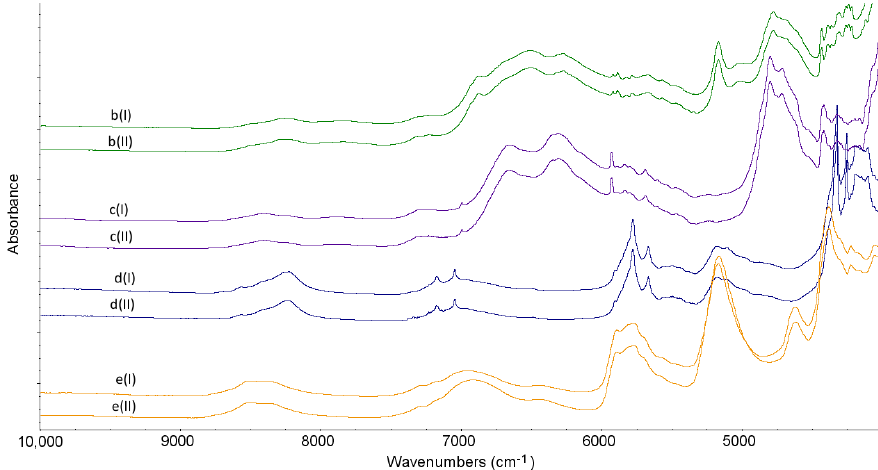
Figure 8 . NIR spectra for lactose (b), mannitol (c), magnesium stearate (d) and polyvinylpyrrolidone (e) in the non-stressed (I) and stressed (II) samples.